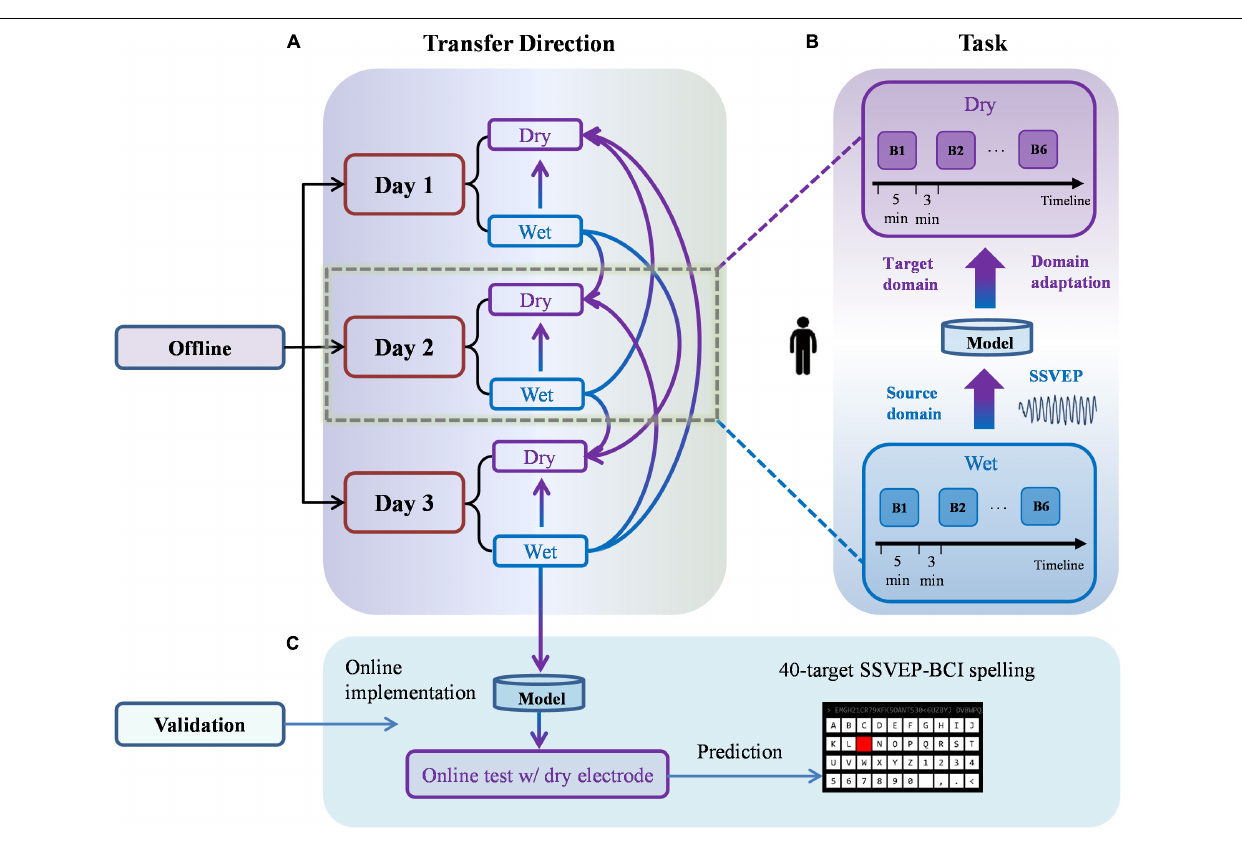
signals between 6 and 90 Hz. A 50-Hz notch filter was used to remove the power frequency noise from the recorded